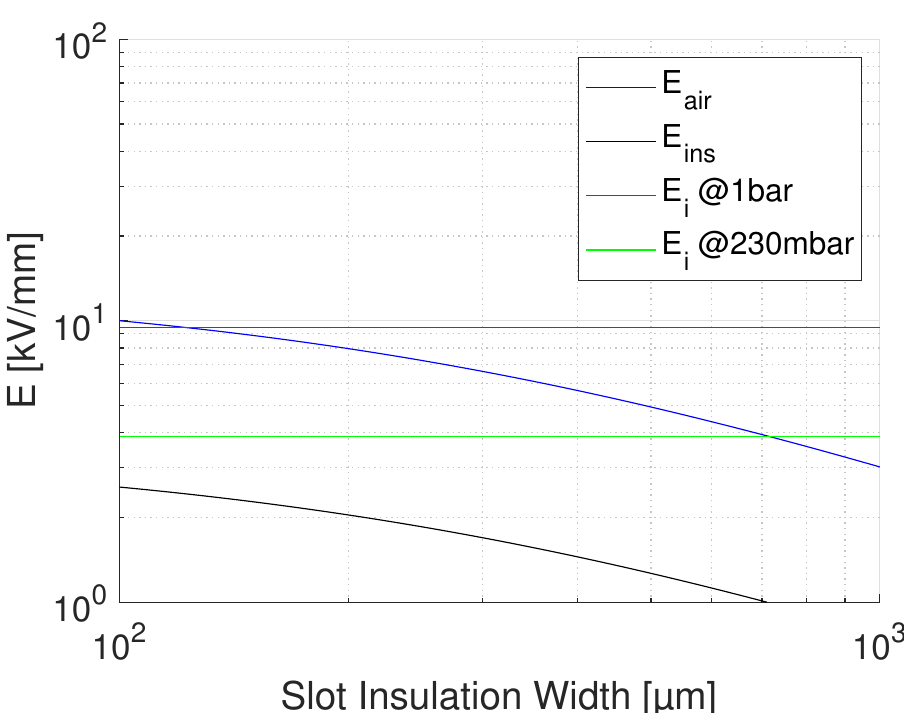
Figure 6. Behavior of PD inception field, E i , as a function insulation thickness (thus slot width) with fixed air gap of 100 µ m. Same parameters of Figure